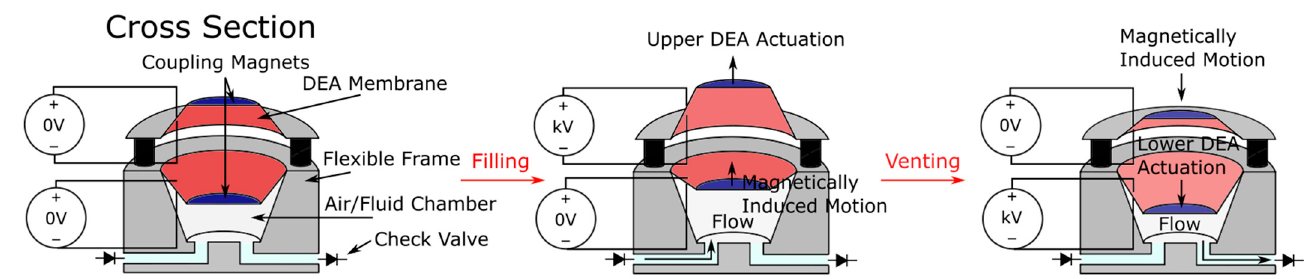
Figure 14. The structure of a magnetically coupled DEA pump. Illustration inspired by Cao et al. [116]. Since the two DEA membranes are magnetically coupled, actuating one will induce a motion of the other. By alternatively actuating the top and bottom DEAs, the air/fluidic chamber will experience alternative negative and positive pressures, which results in the net flow of air or fluid from the left inlet to the right outlet.